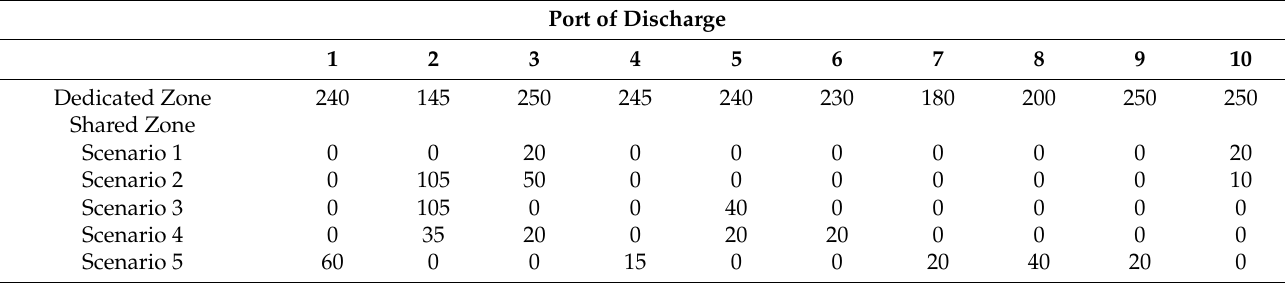
Table 2. Space Allocation using Proposed Dedicated–Shared